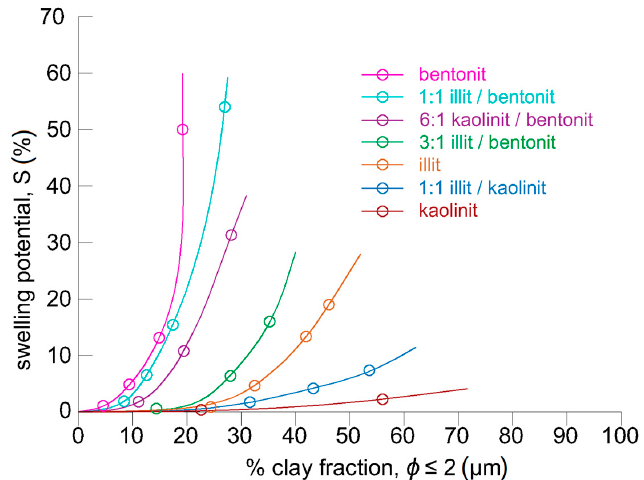
Figure 2. Relationship between swelling potential and clay fraction percentage (after Seed et al.) [28].